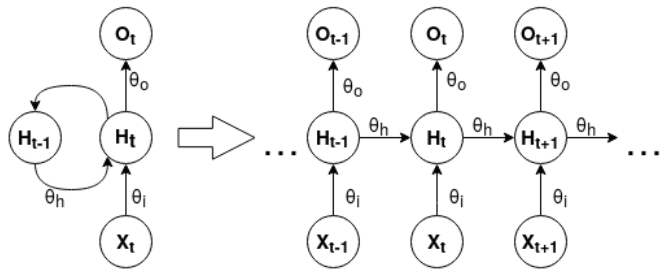
Figure 3. Standard to many RNN in unfold form (influenced by